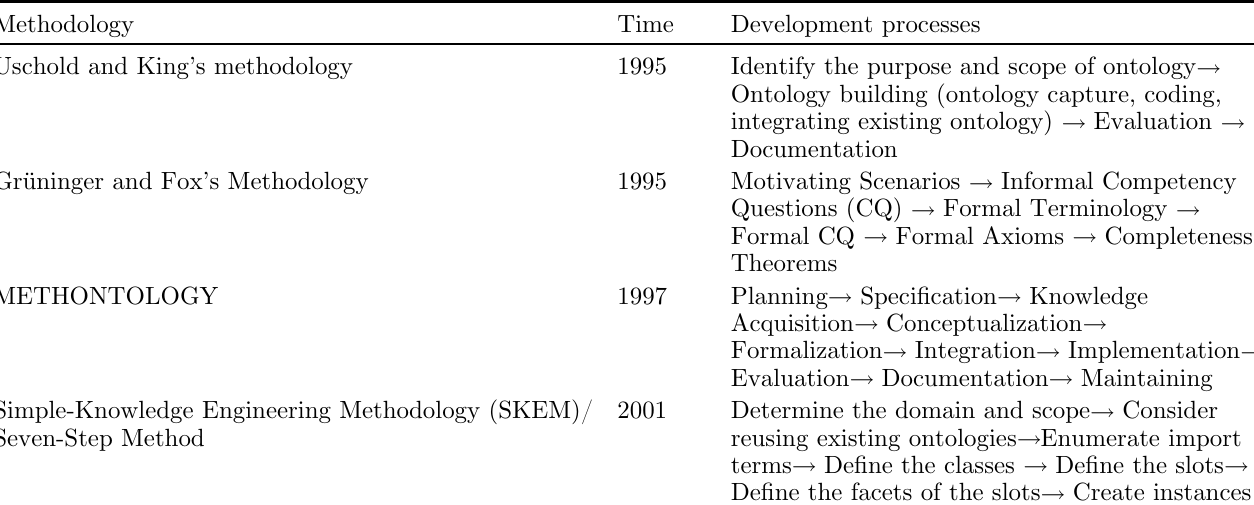
Table 1. Ontology development methodologies.